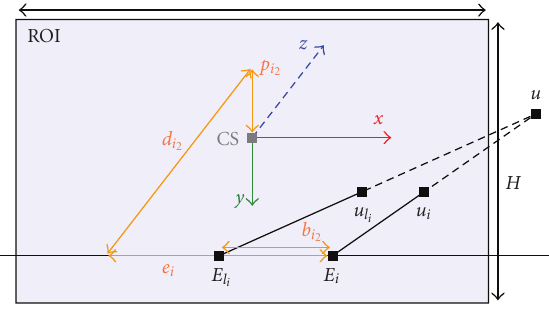
Figure 2: The viewing geometry.